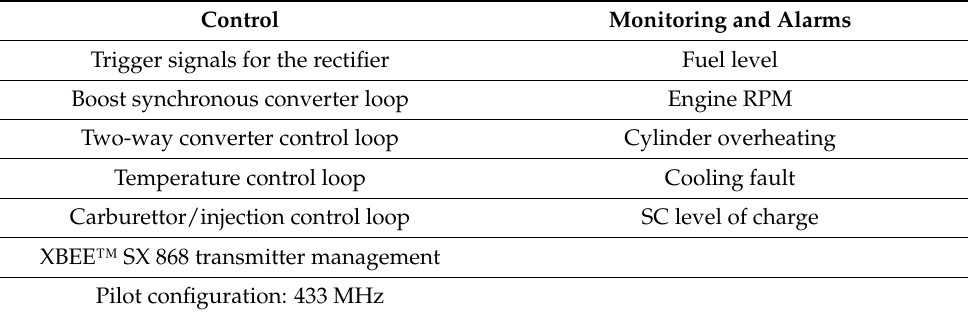
Table 6. Control and monitoring algorithms implemented in the FPGA.